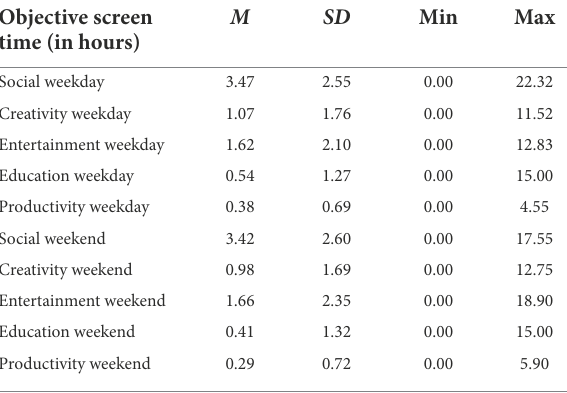
TABLE 1 Means and standard deviations of objective time spent on technology in